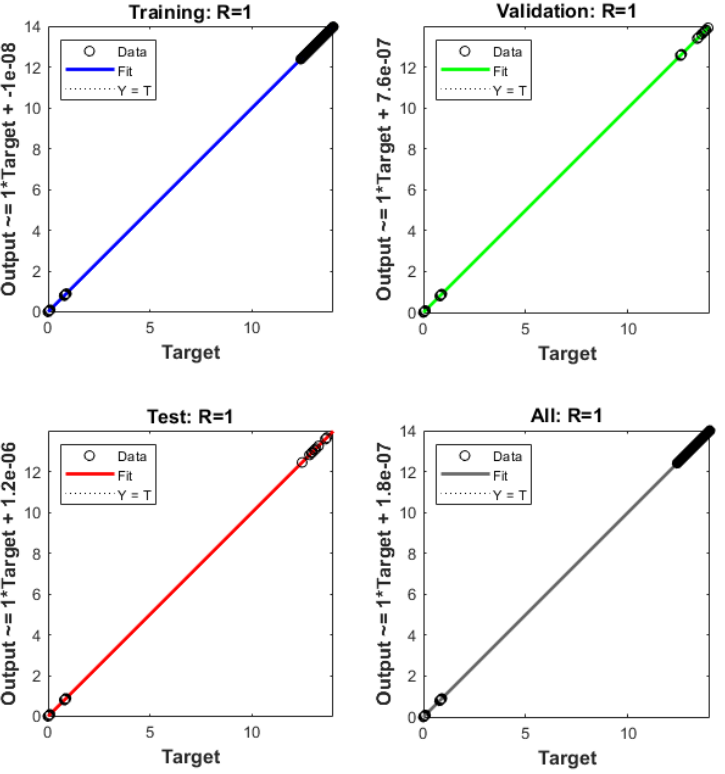
Figure 7. Case 2 Regression plots based on the nonlinear COVID-19 spreading model.